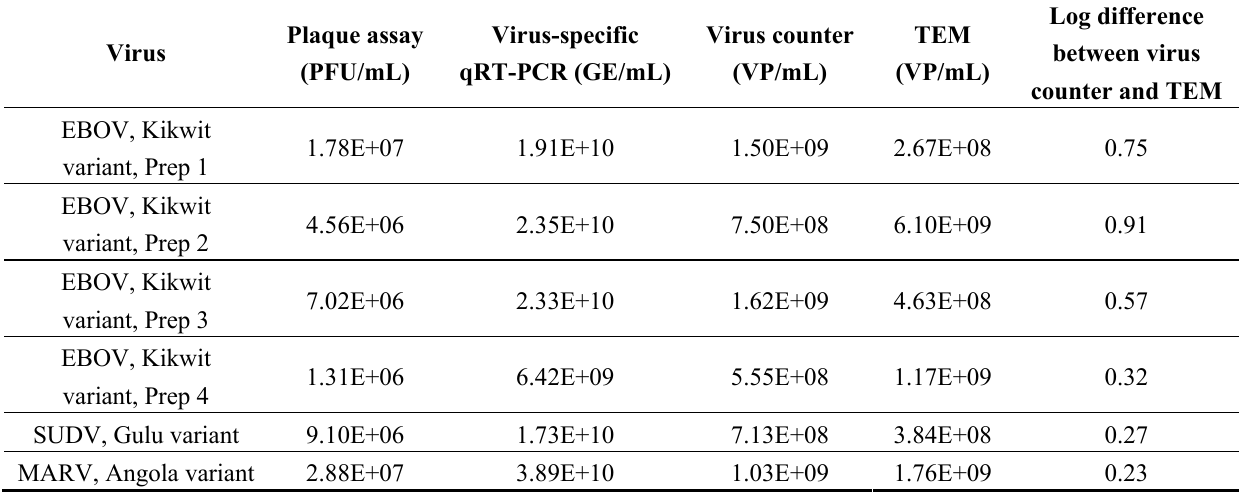
Table 1. Quantitative assay results for different filovirus stocks; Ebola virus (EBOV), Sudan virus (SUDV), and Marburg virus (MARV). Infectious virus titer for each stock as determined by agarose-based plaque assay (PFU/mL), nucleic acid concentration reported as genomic equivalents per mL as measured using a virus-specific qRT-PCR (GE/mL), and virus particle counts per mL (VP/mL) measured using the ViroCyt ® Virus Counter 2100 instrument and transmission electron microscopy (TEM). The log difference in particle counts between the Virus Counter and TEM methods is shown in the last